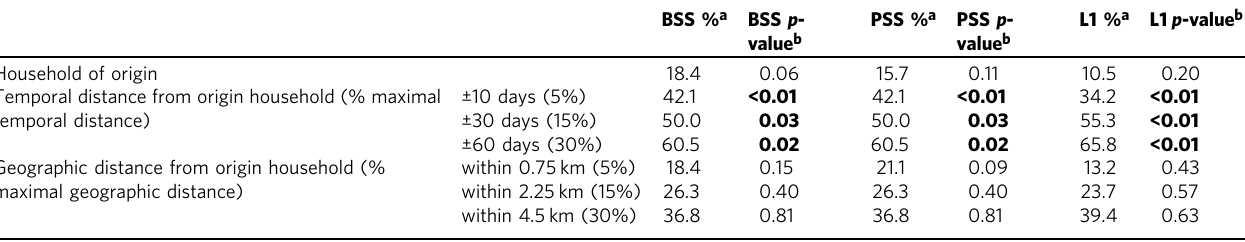
Table 3 Maximal genetic similarity metrics are highly predictive of case child temporal distance from origin household.